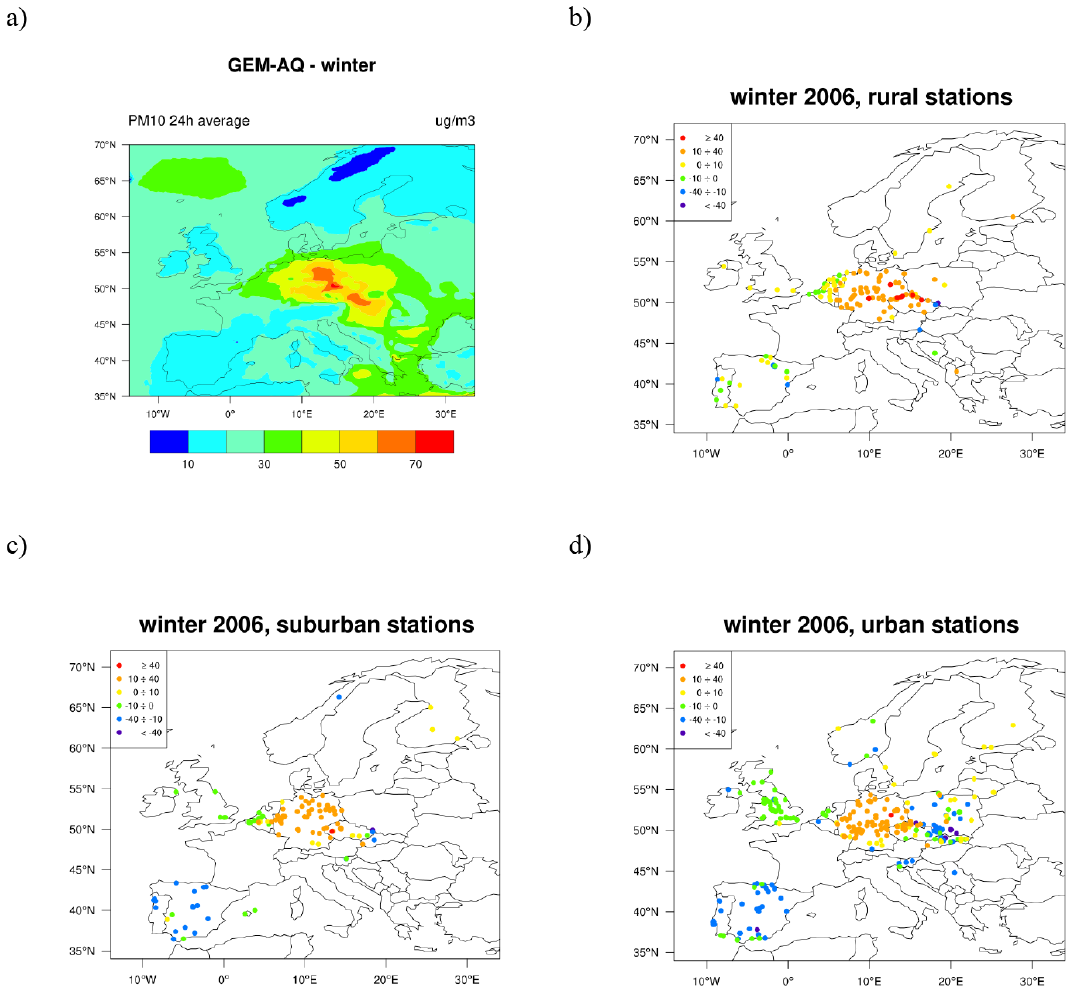
Figure 15. Winter (DJF) 24h average PM 10 concentrations in µgm − 3 (a) , MBE at rural stations (b) , MBE at suburban stations (c) and MBE at urban stations (d)